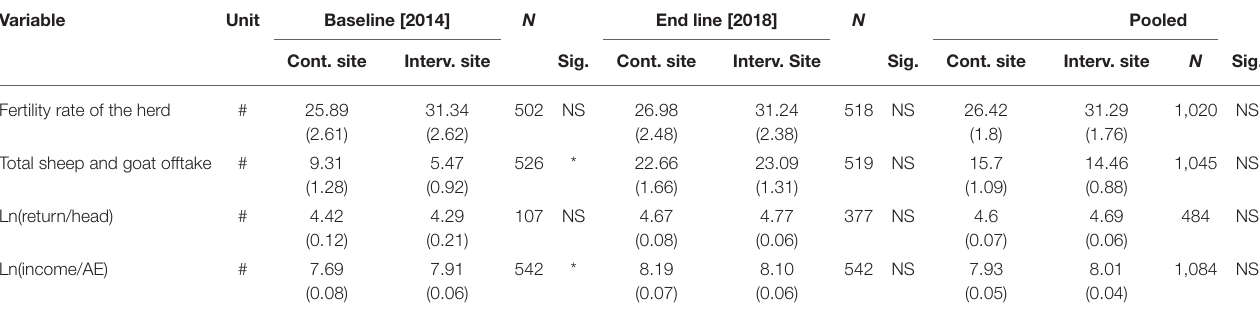
TABLE 4 | Summary statistics of outcome variables. Variable